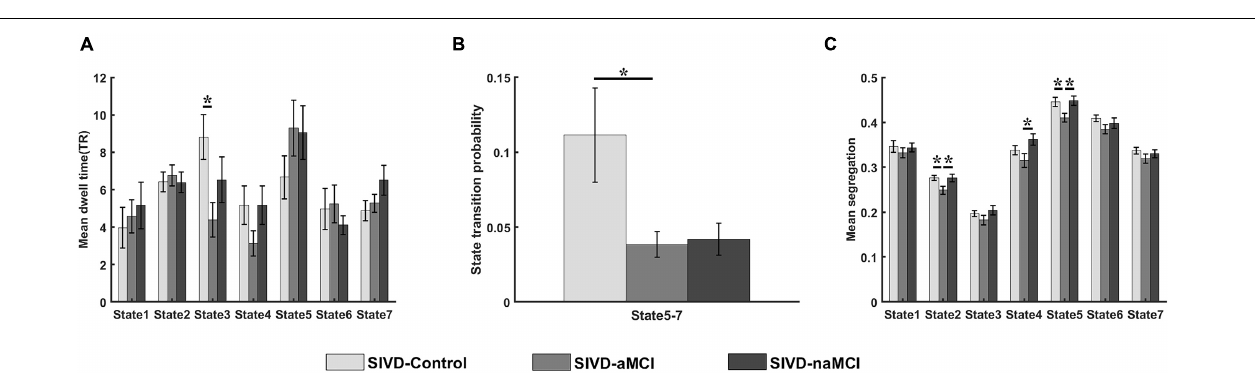
FIGURE 2 | Measurements of dynamic FC for SIVD-Control, SIVD-aMCI and SIVD-naMCI. (A) The mean dwell time of 7 states. (B) The state transition probability that shows significant intergroup differences. (C) The mean system segregation of 7 states. *Represents p < 0.05.